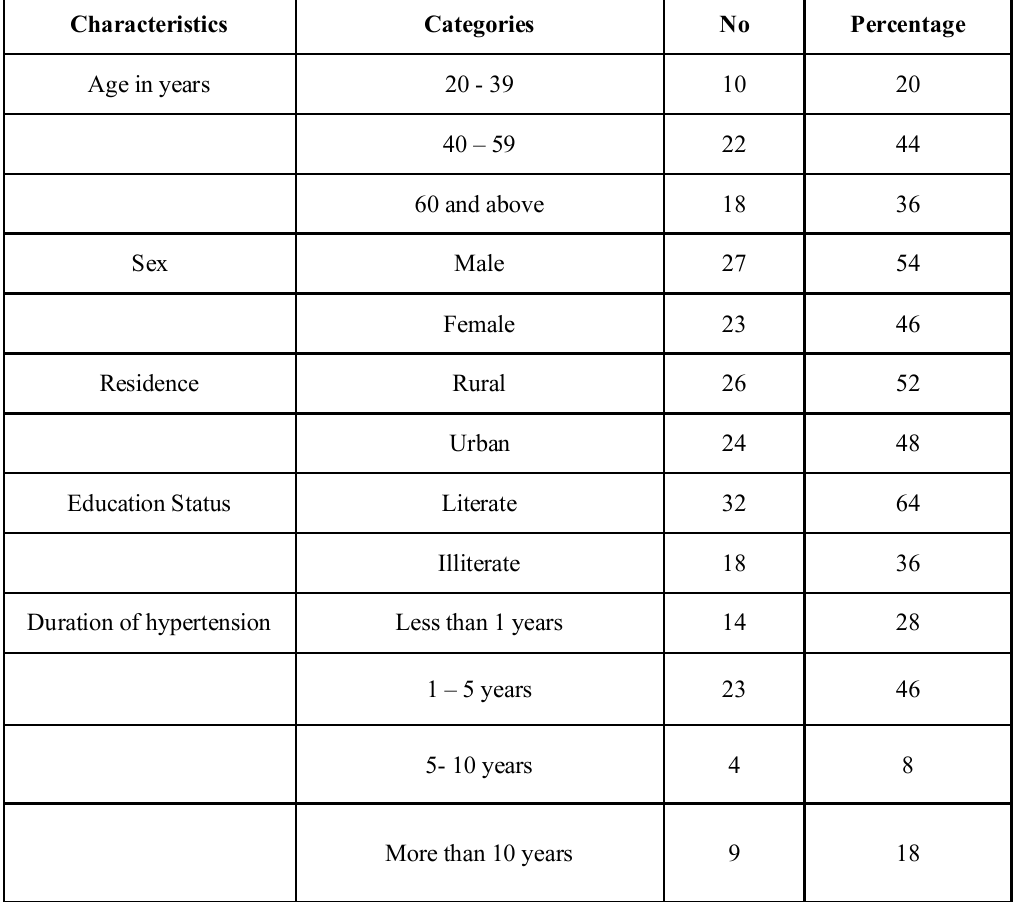
Table 1: Distribution of Socio demographic variables of respondents (N=50)